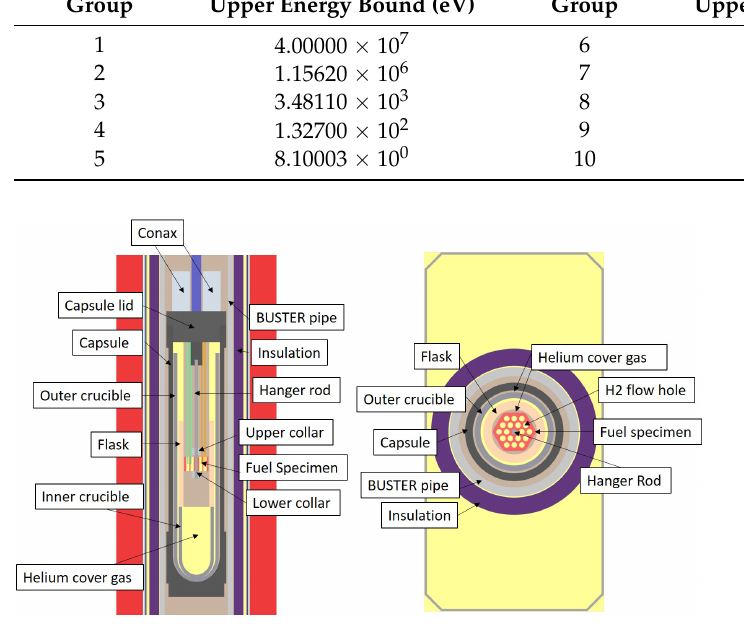
Figure 6. Serpent plots depicting SIRIUS-CAL within the MARCH